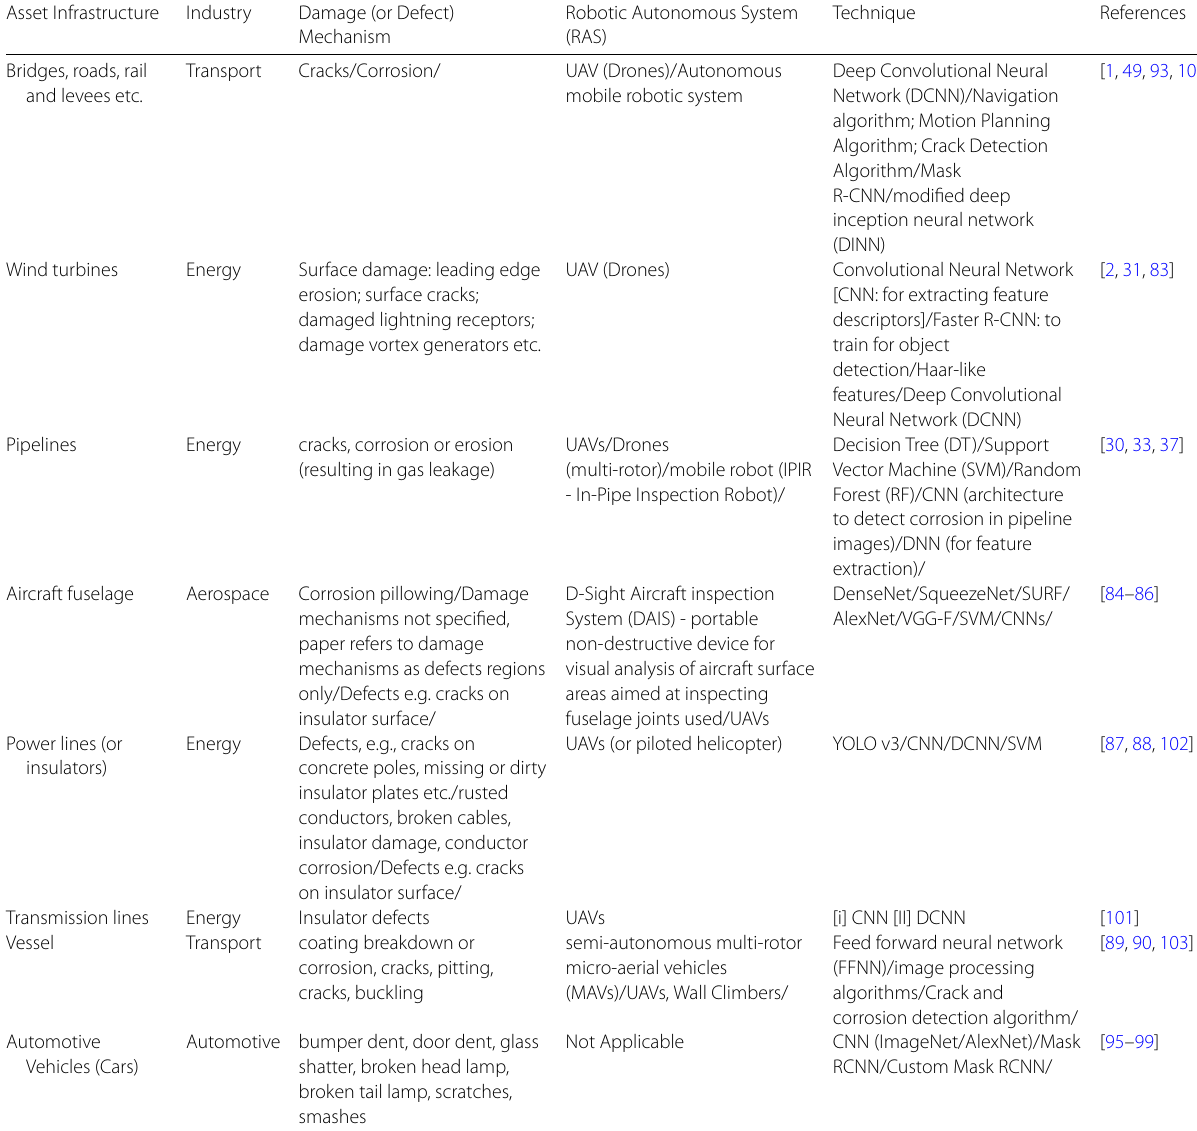
Table 2 Review of collection and analysis of damage mechanisms analysis on civil and mechanical infrastructure Asset Infrastructure Bridges, roads, rail and levees etc.